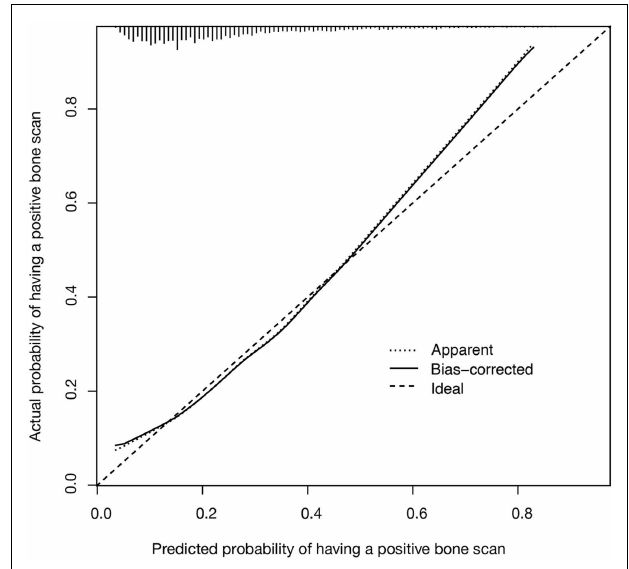
FIGURE 2 | Calibration plot for the nomogram model showing predicted vs. actual likelihood of having a positive bone scan is shown . The vertical lines along the top of the figure show the distribution of nomogram-predicted probabilities for patients in the study cohort.